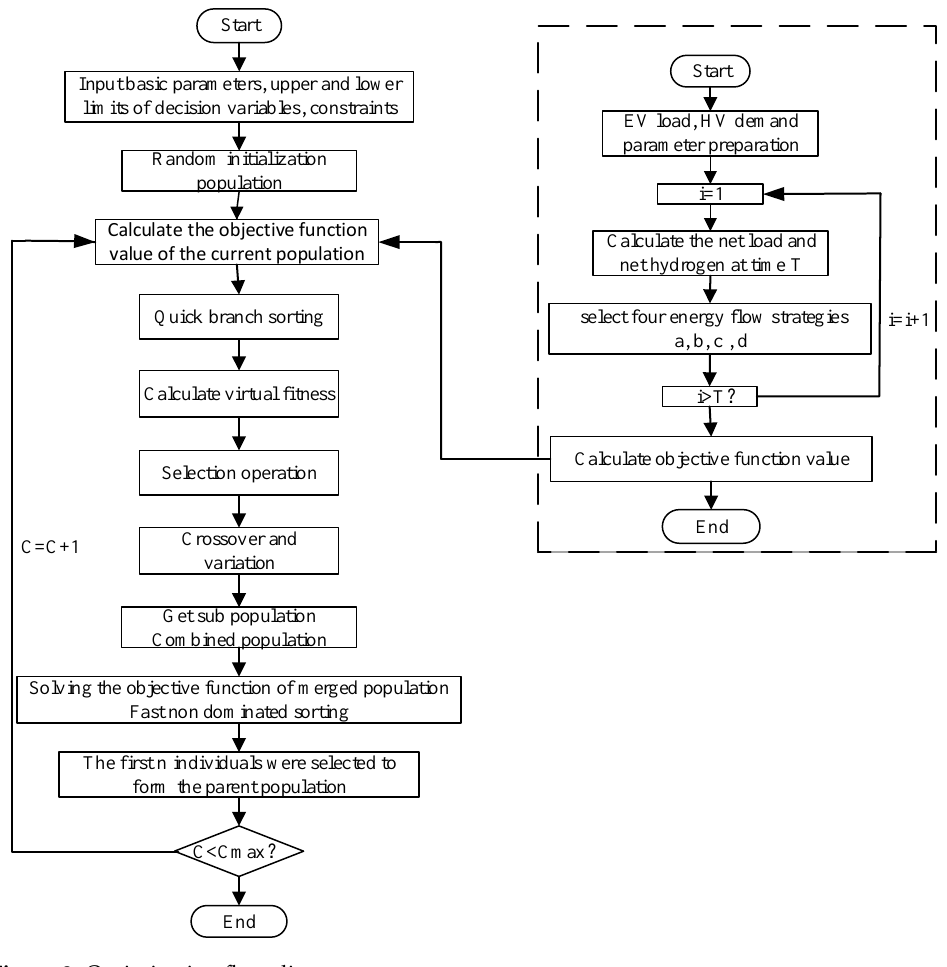
Figure 3. Optimization flow diagram.